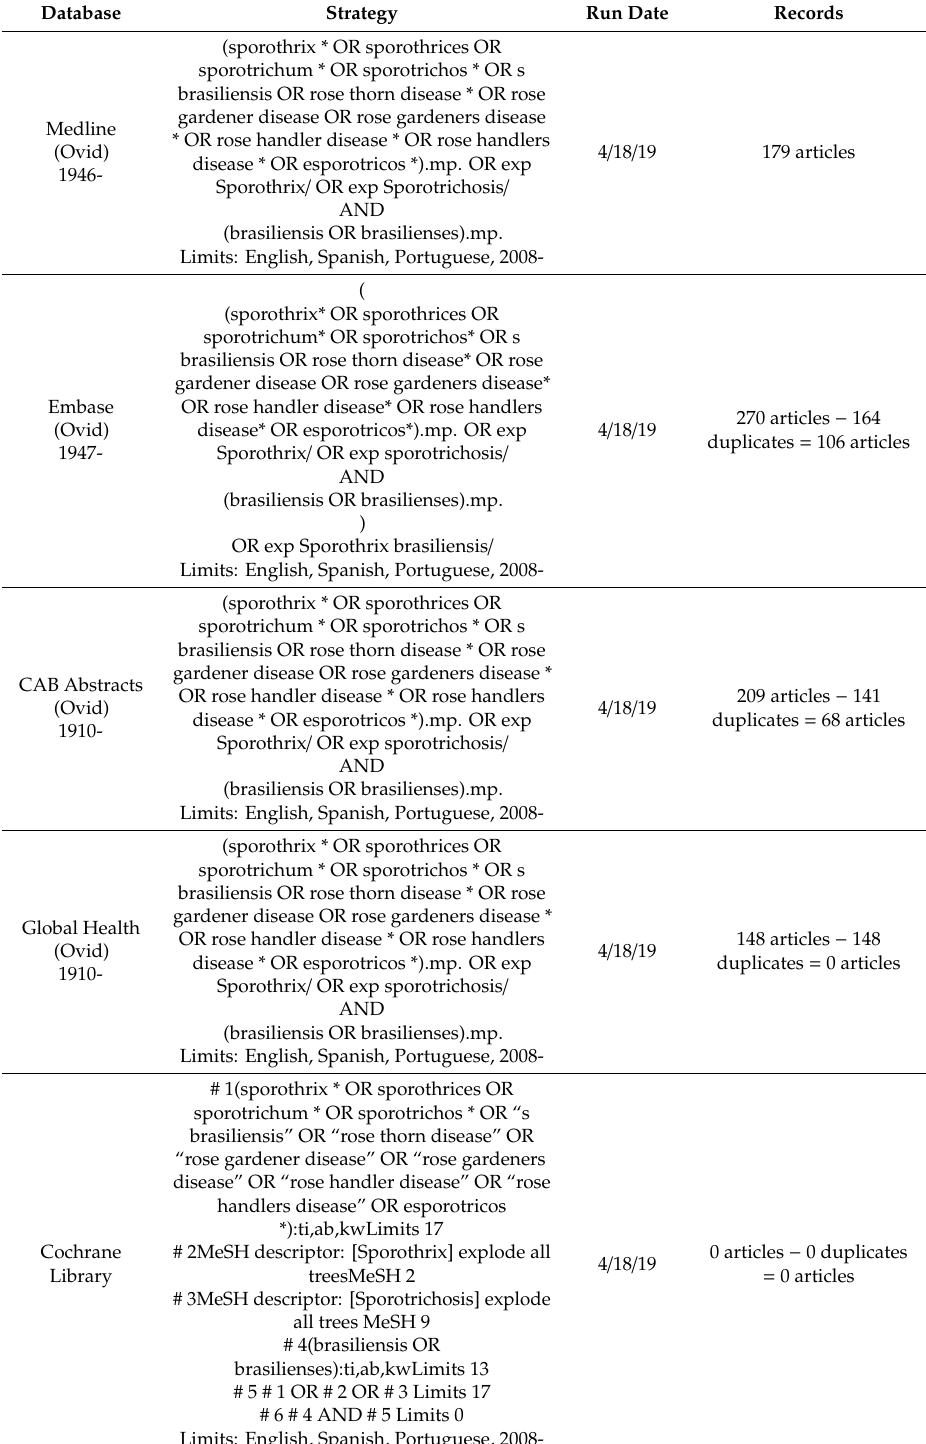
Table A1. Sporothrix